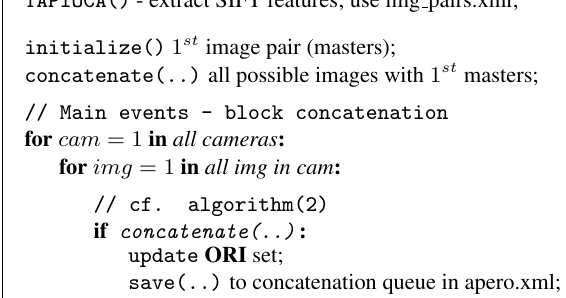
Algorithm 1: Pseudocode of image concatenation in initial